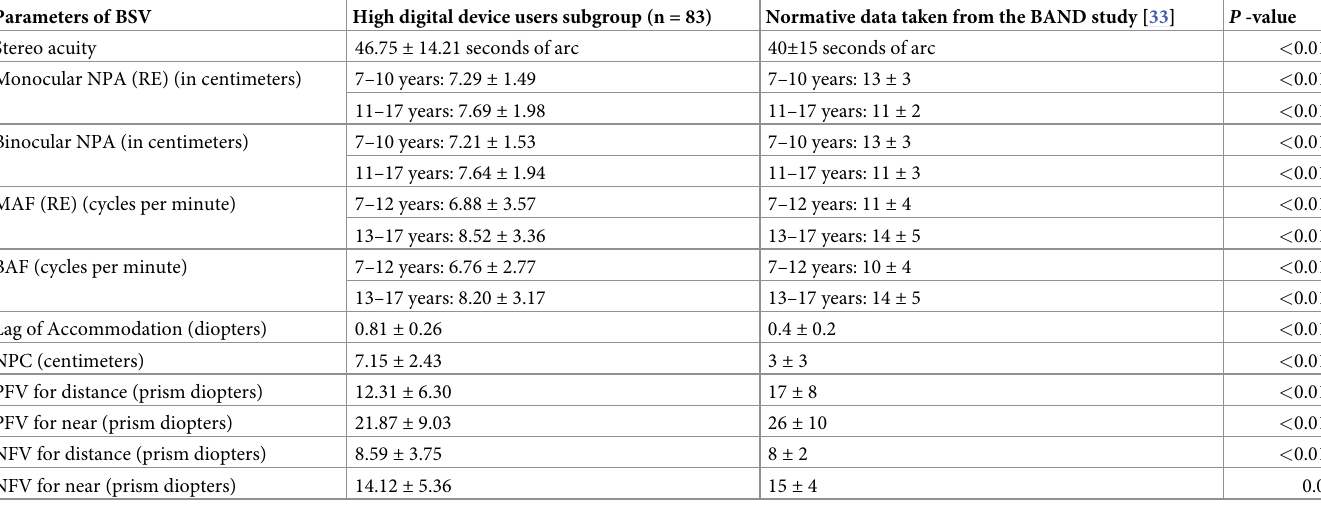
Table 3. Comparison of high digital device users subgroup with the normative data taken from the BAND study. Parameters of BSV High digital device users subgroup (n = 83) Normative data taken from the BAND study